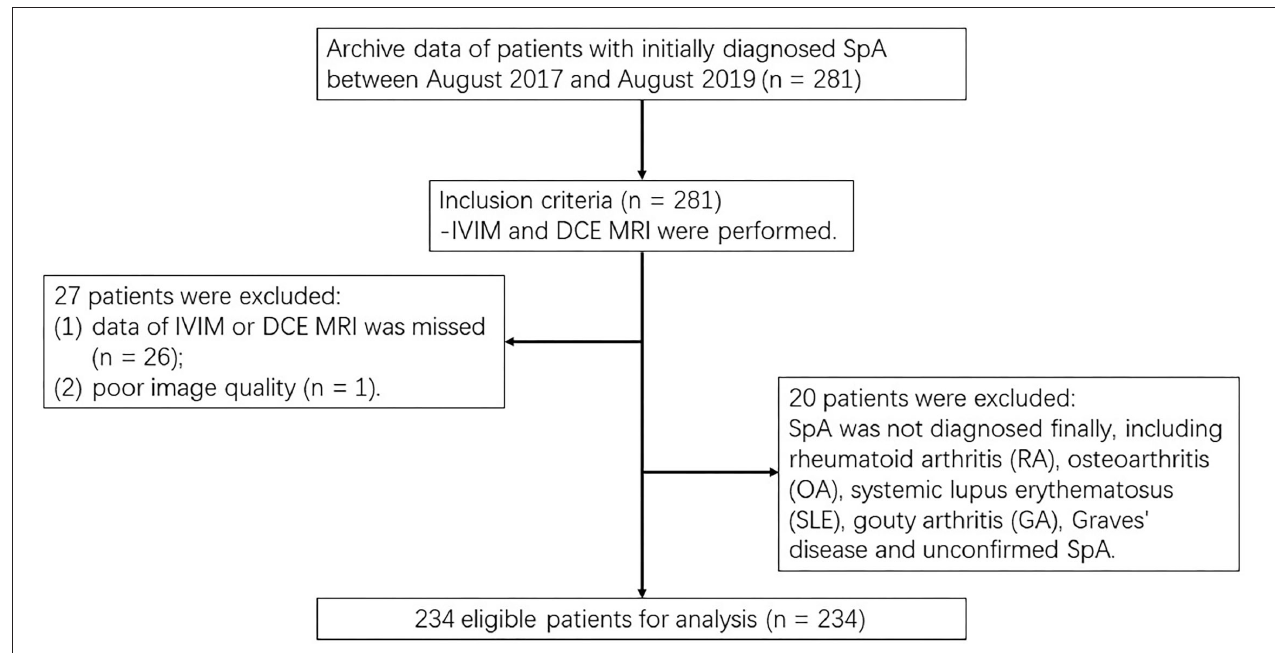
FIGURE 1 | Flow diagram for patient